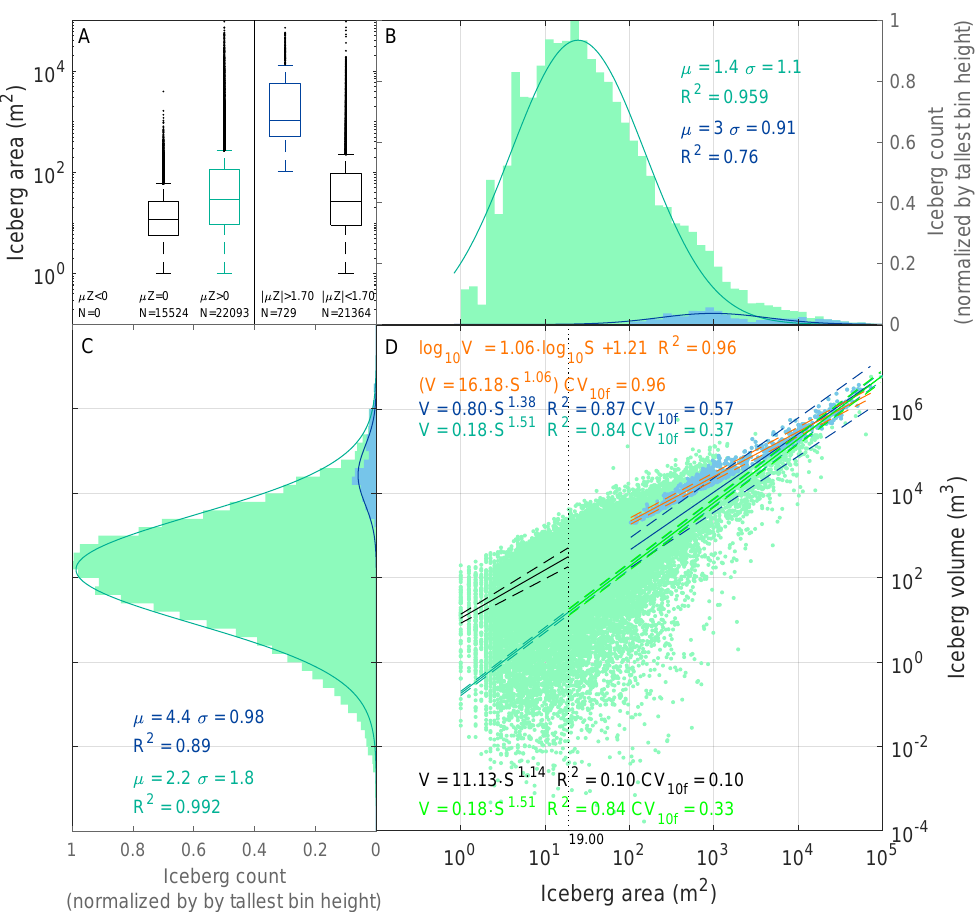
Figure 14. Results of filtering and model fitting to the area–volume data. DREM 0 with negative values replaced with 0 used: ( A ) area distributions of iceberg classes selected by µ Z rel ; ( B ) histograms of iceberg area; ( C ) histograms of iceberg volume; and ( D ) power law relationship fitted to the area/volume data. Green fields indicate whole µ Z rel > 0 dataset, blue—data filtered. Green lines are models (Gaussian distributions in ( B , C ), power law models in ( D )) fitted to unfiltered data, blue—to the filtered data. Orange line is a linear model fitted to the log-log data. Dashed lines indicate 95% confidence intervals of